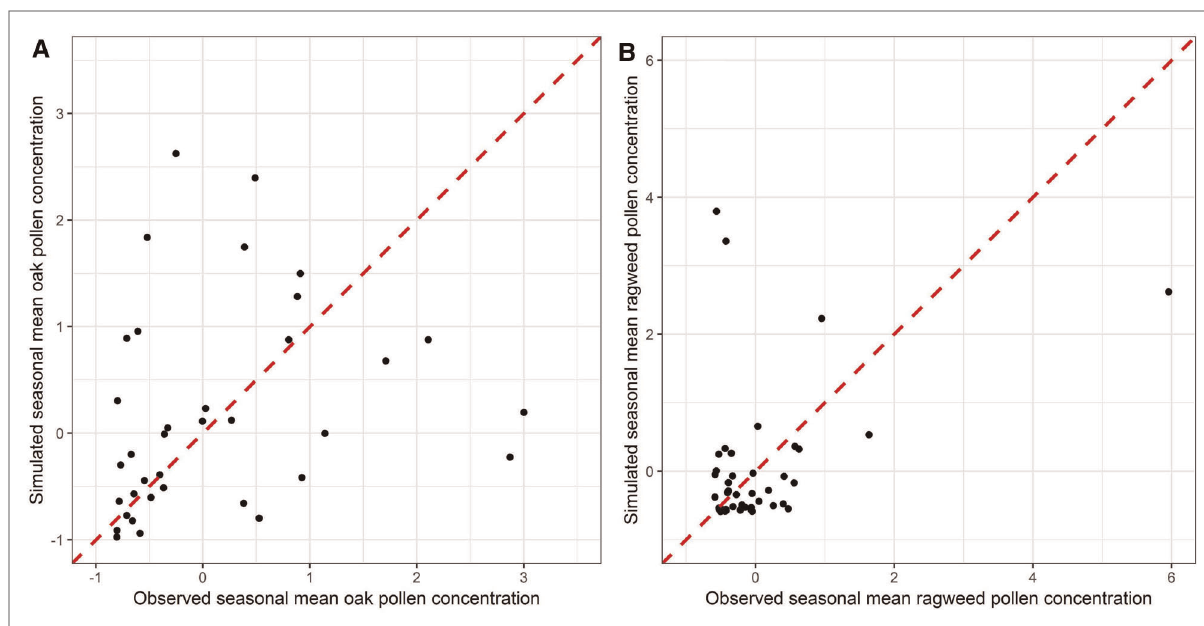
FIGURE 4 Scatterplots of normalized observed seasonal mean concentrations and simulated seasonal mean concentrations in 2004 for ( A ) oak and ( B ) ragweed pollen at pollen monitoring stations with available